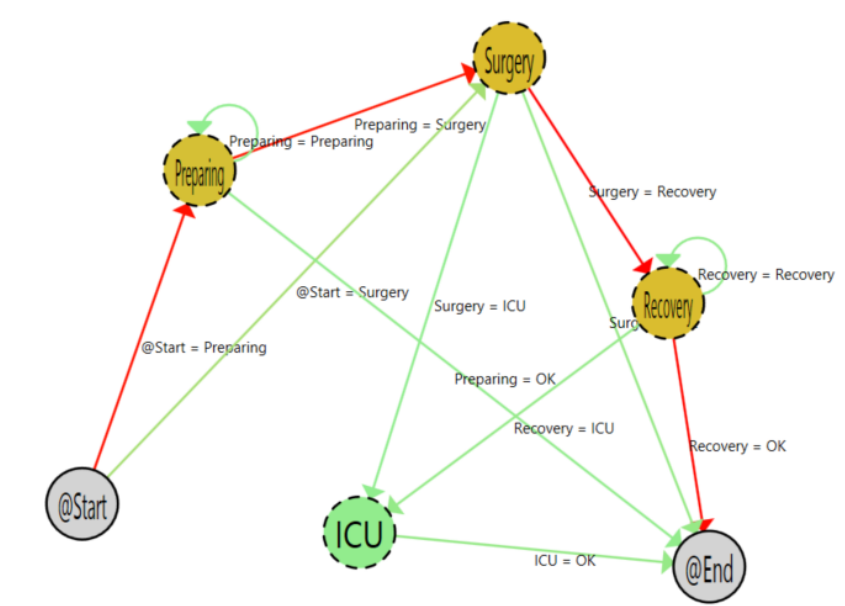
Figure 9. Post-hospitalized patient process.